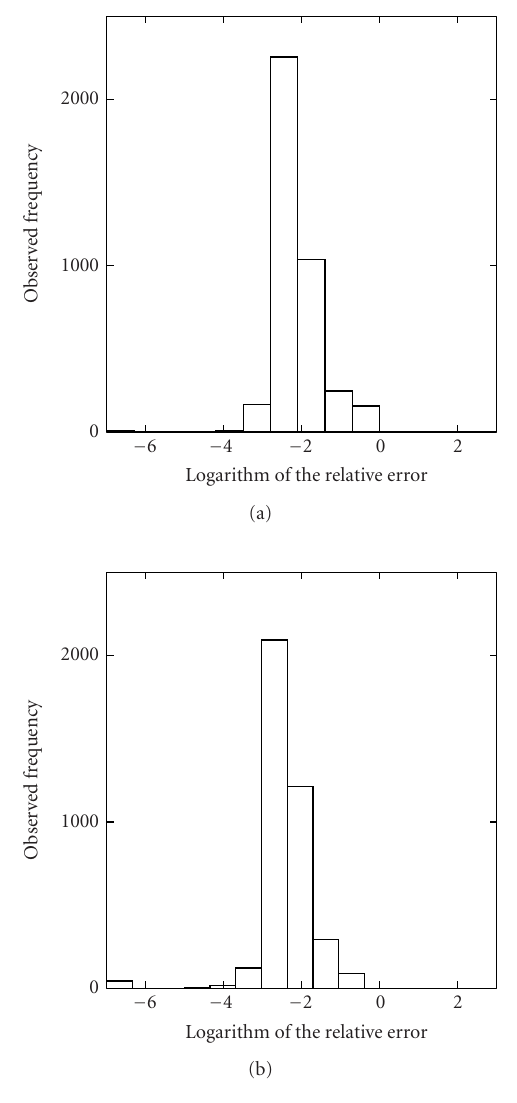
Figure 9: Histogram of logarithmic relative error values for the pro- posed FFT with input signals x (a) and 4 x (b), the error increases to the right.